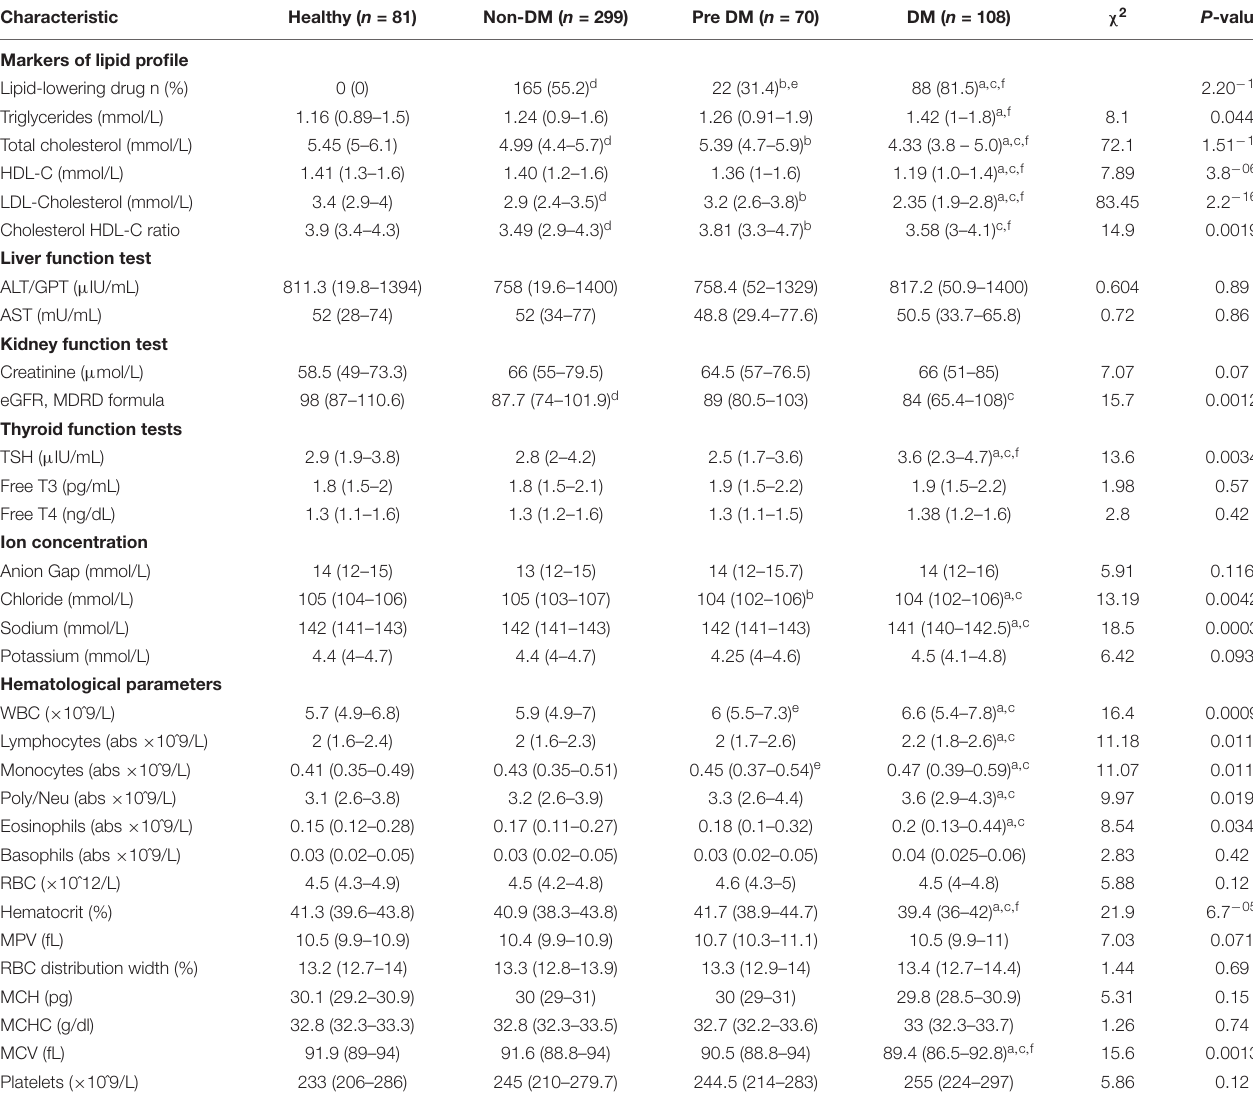
TABLE 2 | Basic clinical of